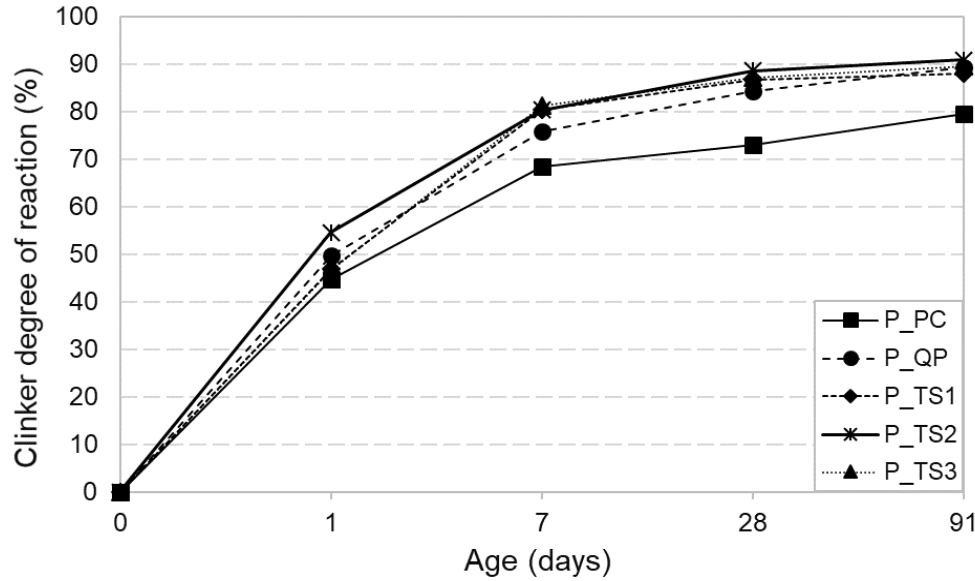
Figure 7. The clinker degree of reaction in different pastes up to the age of 91 days.